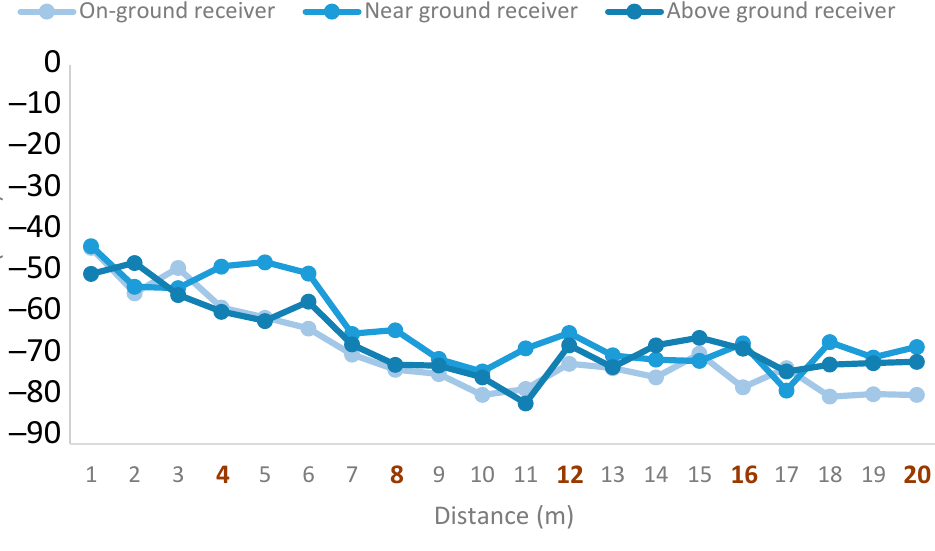
Figure 17. Emitter at height of 2 m.